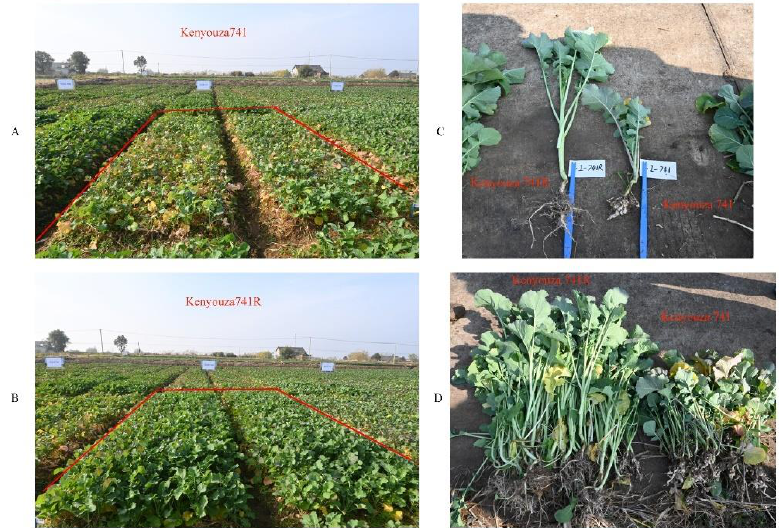
Figure 4. Investigation of clubroot resistance in Kenyouza 741R and Kenyouza 741. ( A , B ) Field phenotypic investigation of Kenyouza 741 and Kenyouza 741R. The observation area is shown in the red line frame of ( A , B ). ( C , D ) Comparison of root phenotype investigation of Kenyouza 741R and Kenyouza 741.